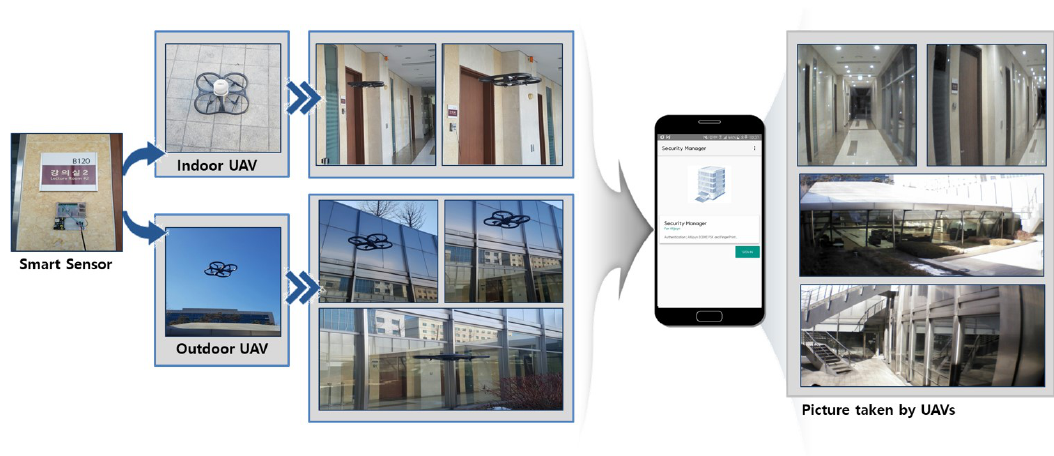
Figure 9. The experimental flow of the day-to-day monitoring process.